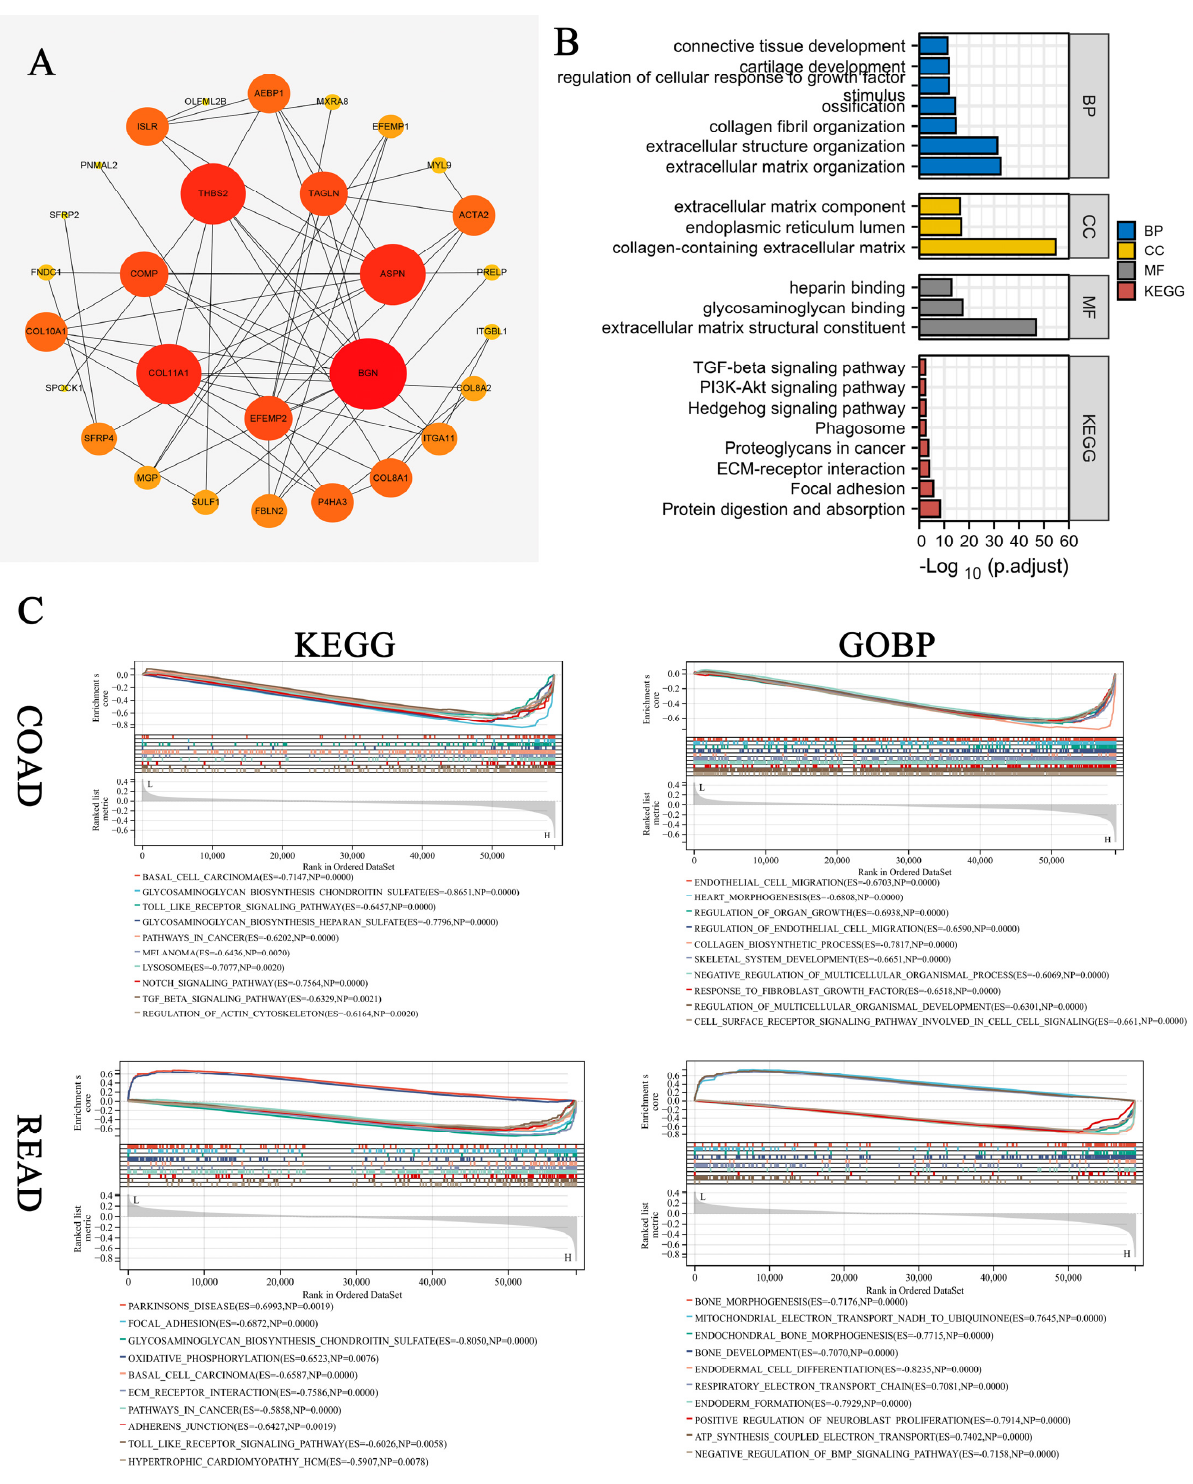
Figure 8. The function analysis of COMP-related genes. ( A ) The protein–protein interaction network of COMP-related genes. ( B ) GO and KRGG pathway enrichment analysis of COMP-related genes. ( C ) GSEA analysis with samples divided via median COMP expression level for COAD and READ.